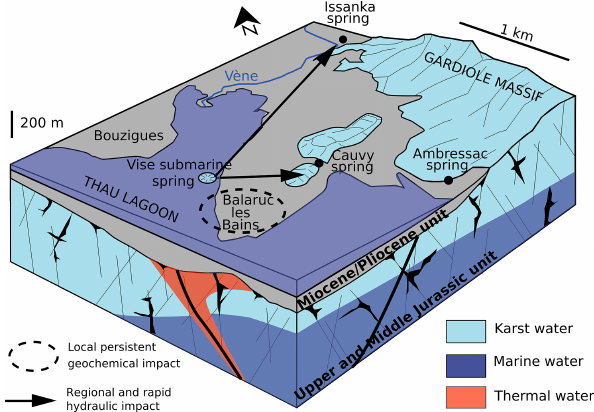
Figure 10. Block diagram of the study area showing the spatial ex- tent of the hydraulic and geochemical